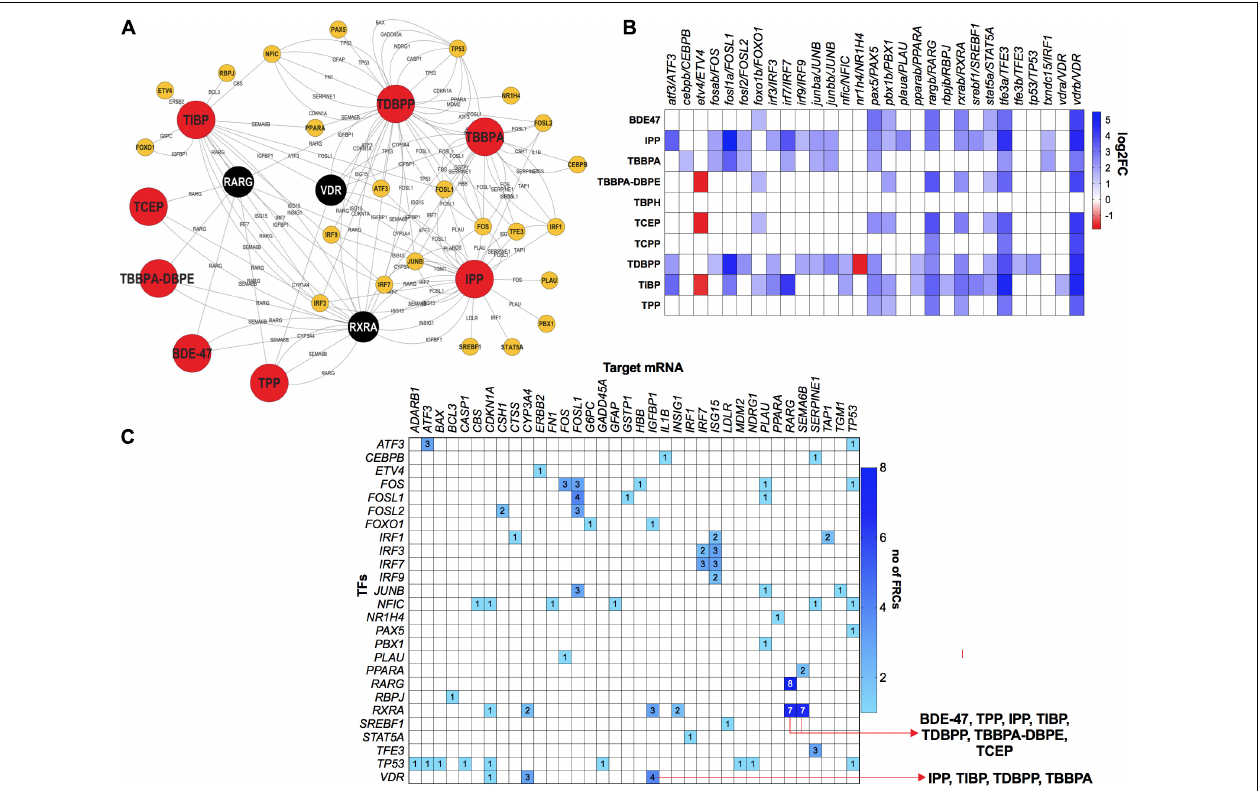
FIGURE 7 | mRNA-transcription factor (TF) interactions across FRCs according to experimentally validated predictions. (A) FRC-mRNA-TF regulatory network based on TFmiR gene-TF interactions. • FRCs, • TFs. • (black nodes with white text)-TFs that were differentially expressed across 5 or more FRCs, with larger nodes denoting higher number of FRCs. (B) Heatmap representing fold changes of selected TFs across all FRCs. Both zebrafish and human orthologs are provided. (C) Heatmap representing mRNA-TF combinations that were co-altered across multiple FRCs. Numbers within cells represent number of FRCs that a specific pair was altered in. Red arrows represent the FRCs for specific pairs that are discussed in the manuscript. All data based on TFmiR experimentally validated